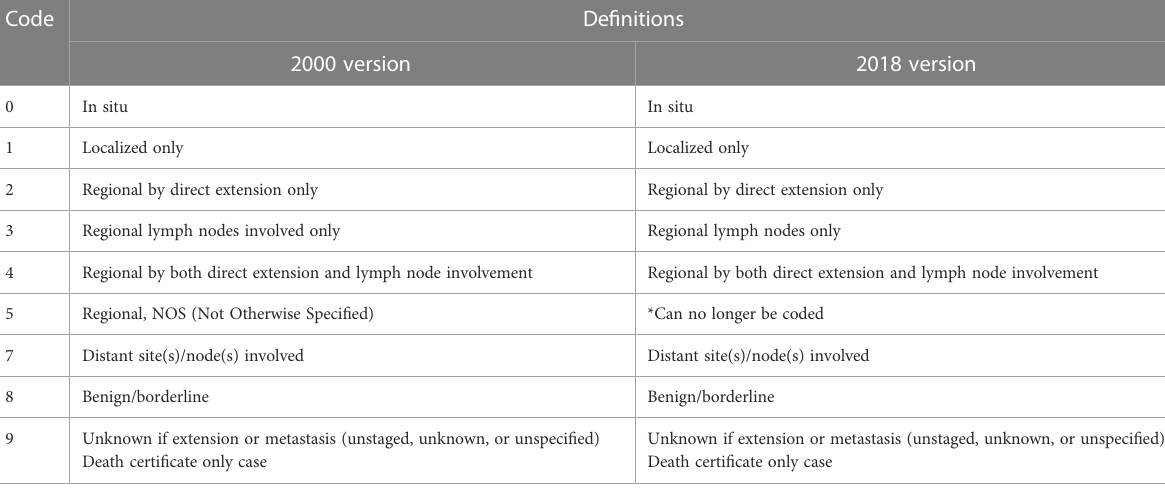
TABLE 1 Description of different categories used in the 2000 and 2018 versions of the SEER summary stage.